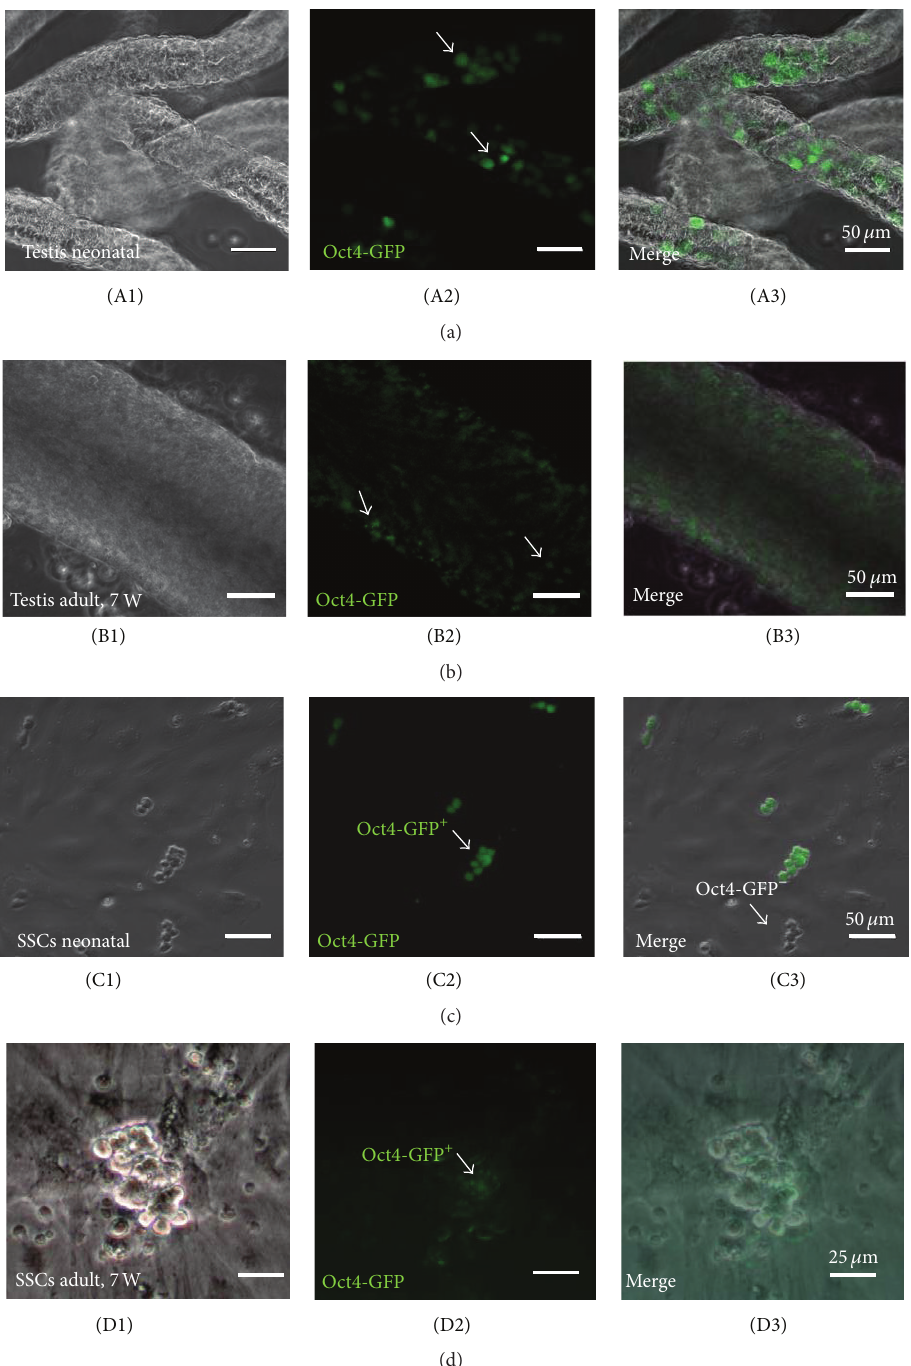
Figure 1: Number and intensity of GFP signals in the neonate and adult mouse testicular tubules (a, b) and SSC cultures (c, d) from transgenic Oct4-GFP reporter mice. (A1–A3) In the freshly dissected testicular tubules, the number of Oct4-GFP positive cells and the intensity of the Oct-GFP signal were higher and stronger in neonate mice than in adult mice > 7 weeks (B1–B3). (C1–C3) Oct4-GFP positive SSCs were clearly presentduringinitialculturesfromneonatemice,whileinadultmice > 7weeksSCCsOct4-GFPsignalsweremuchweakerfromthebeginning (D1–D3). SSC colonies were grown on MEF feeder layers. (A1–D1) bright field; (A2–D2) green fluorescence for Oct4-GFP; (A3–D3) merged images. Scale bars: (a)–(c) 50 𝜇 m, (d) 25 𝜇